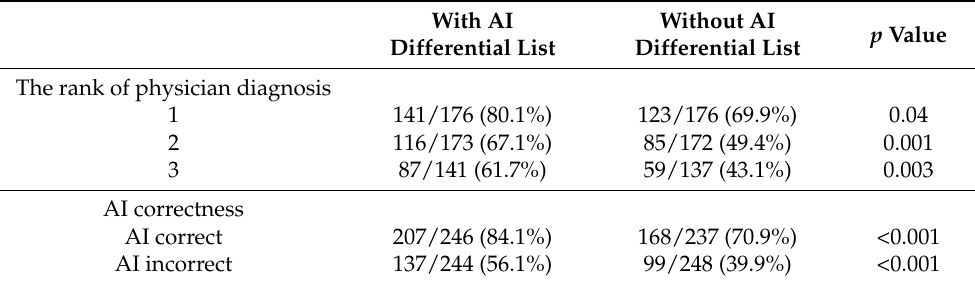
Table 2. Prevalence of physician diagnosis identical with the differential diagnosis of AI.